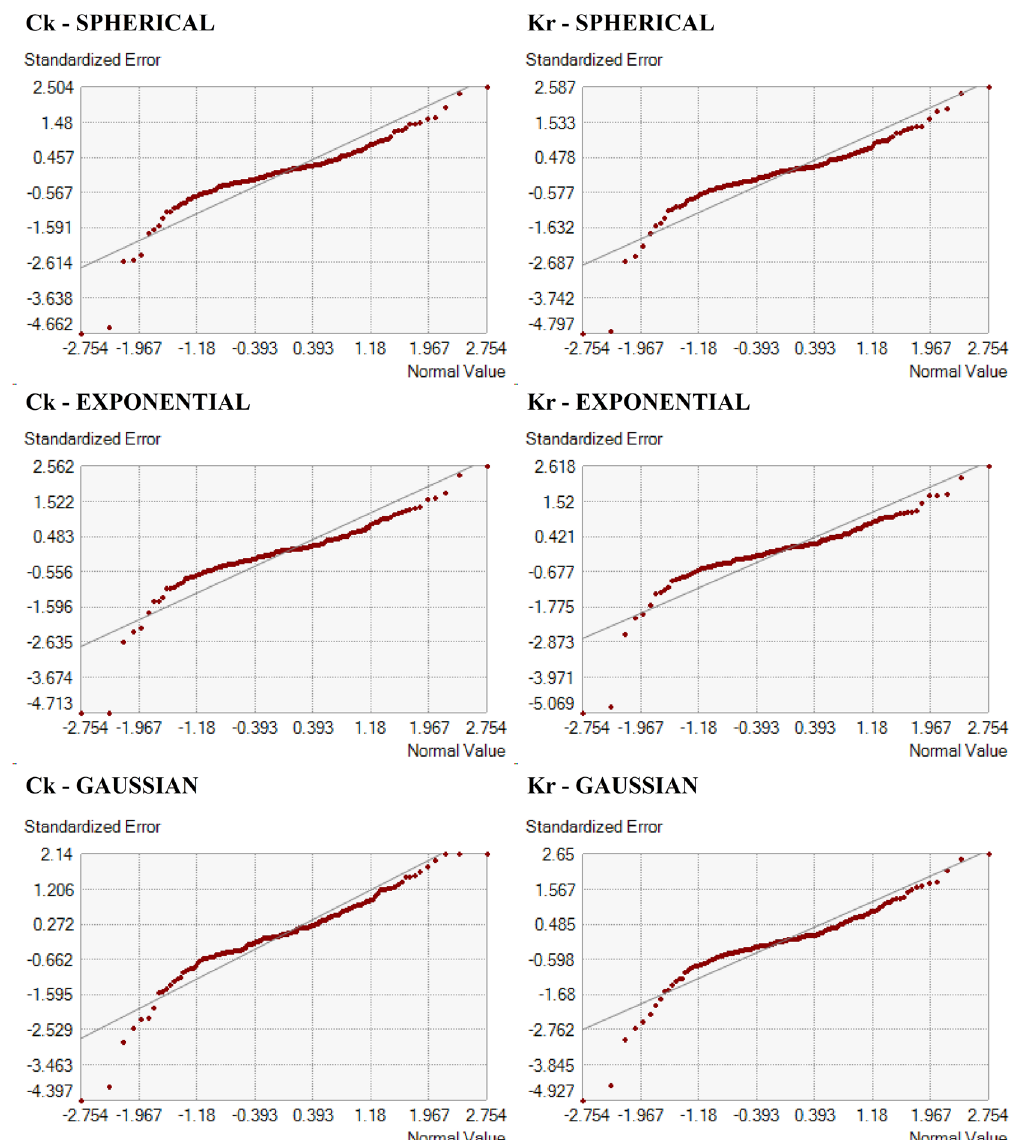
Figure 5. Normal Quantil-Quantil graphs for the annual rainfall interpolations in the